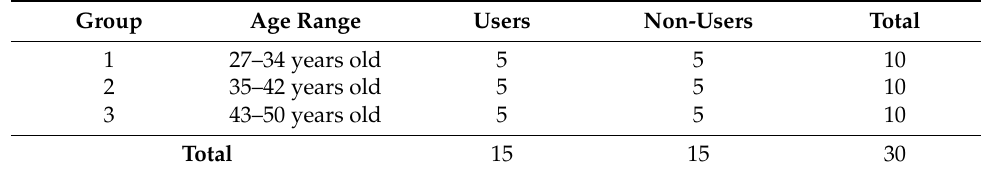
Table 1. Summary of informants. Group Age Range Users Non-Users